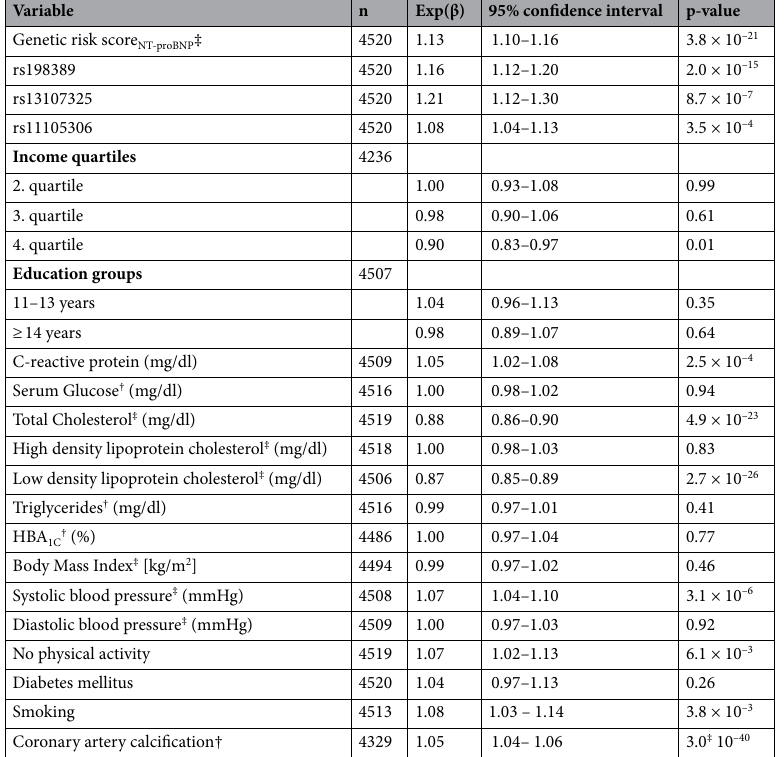
Table 3. Exp(β) and 95% confidence intervals (95% CI) for the association of genetic, socioeconomic and cardiovascular risk factors with NT-proBNP in separate linear regression models, adjusted for sex and age (lowest income/education group as reference). ‡ Exp(β) per standard deviation. † Exp(β) per interquartile